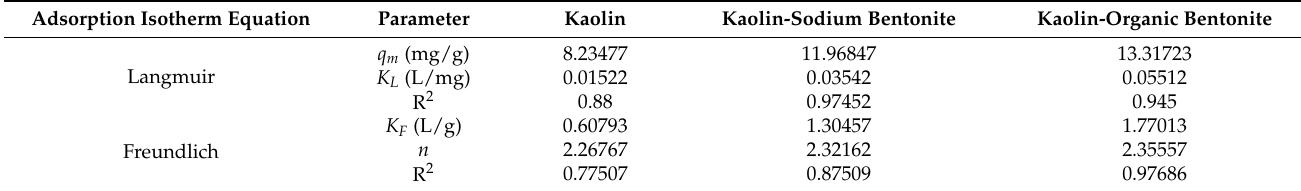
Figure 9. Adsorption isotherms of rhodamine B by different adsorbents: ( a ) Langmuir equation, ( b ) Freundlich equation. Table 2. Adsorption isotherm